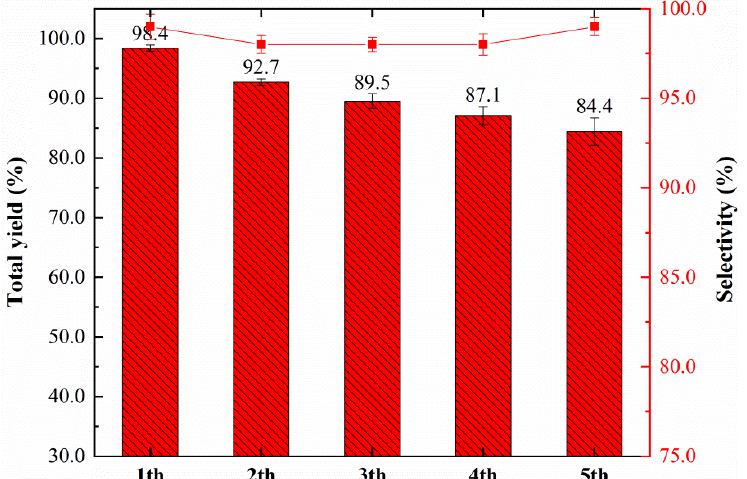
Figure 10. Recycle study of nano-Fe/Pd catalyst for acetylene dicarbonylation and selectivity of production (red line). Reaction conditions: catalyst (10 mg), acetylene (11 mmol), MeOH (20 mL), KI (80 mg), PCO = 1.8 MPa, P total = 4.0 MPa, T = 323.2 K, t = 8 h.